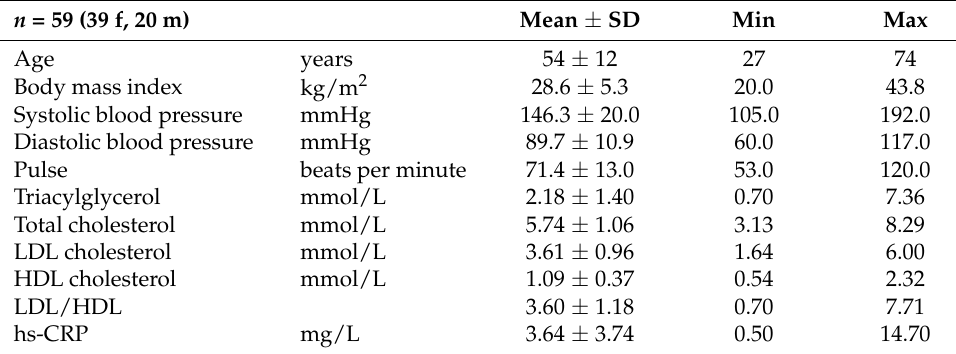
Table 1. Baseline characteristics of the study